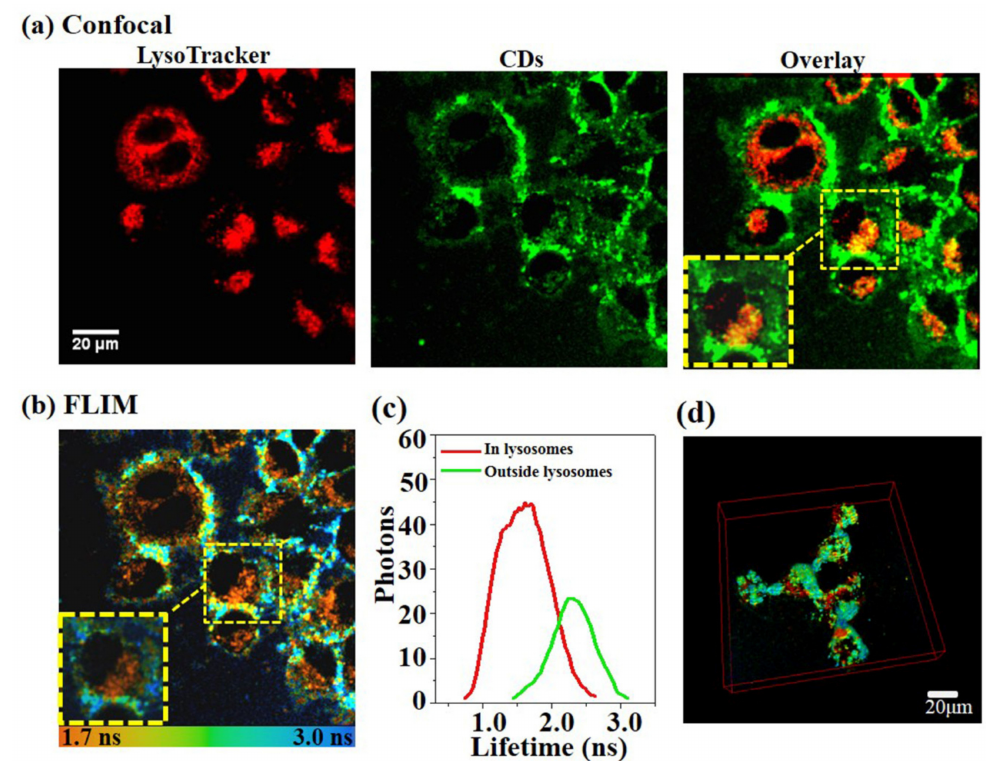
Figure 3. HeLa living cells incubated with CDs and a lysotracker. ( a ) Confocal microscopy of HeLa cells, left to right, lysosomes (red), CDs (green), and an overlay image, in which yellow indicates the co-localization of the CDs and lysosomes. ( b ) FLIM image of CDs in HeLa cells. ( c ) Statistical distribution of the fluorescence lifetimes of CDs inside lysosomes and outside lysosomes in HeLa cells. ( d ) Three-dimensional reconstruction of the FLIM images with 10 frames, 2.45 µ m per step. The colors represent the average lifetime of the CDs, from red to blue, corresponding to 1.7–3.0 ns. Scale bar: 20 µ